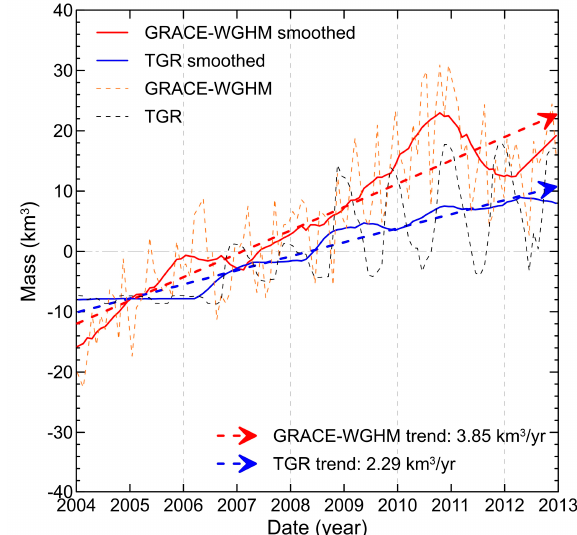
Figure 7. Volume changes estimated for the GRACE-minus-WGHM model (dashed orange curve for the original and solid red curve for the smoothed results) and the TGR prediction based on in-situ measurements (dashed black curve for the original and solid blue curve for the smoothed results).